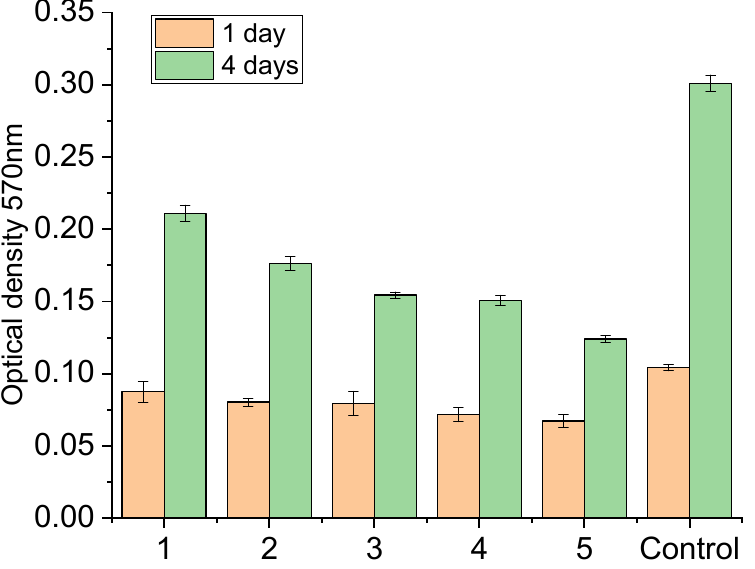
Figure 12. МТТ tests of human dermal fibroblasts cultivated on the surface of films for 1 and 4 days: ( 1 ) CS, ( 2 ) CS-0.5 wt.% SW С NT, ( 3 ) CS-2 wt.% SW С NT, ( 4 ) CS-2.5 wt.% SW С NT, ( 5 ) CS-3 wt.% SW С NT. Control: the cells seeded on the surface of cultural plane (treated polystyrene sur- face).